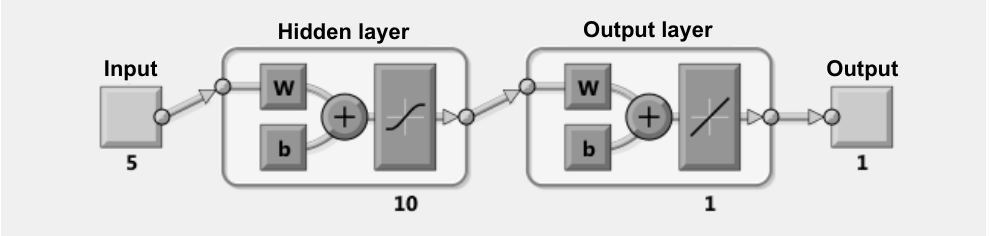
Figure 2. Schematic representation of a simple artificial network model. The artificial neuron has five input variables, for the intended output. These inputs are then assigned weights ( w ) and bias ( b ), and the sum of all these products ( P ) is fed to an activation function ( f ) . The activation function alters the signal accordingly and passes the signal to the next neuron(s) until the output of the model is reached (Mathworks,